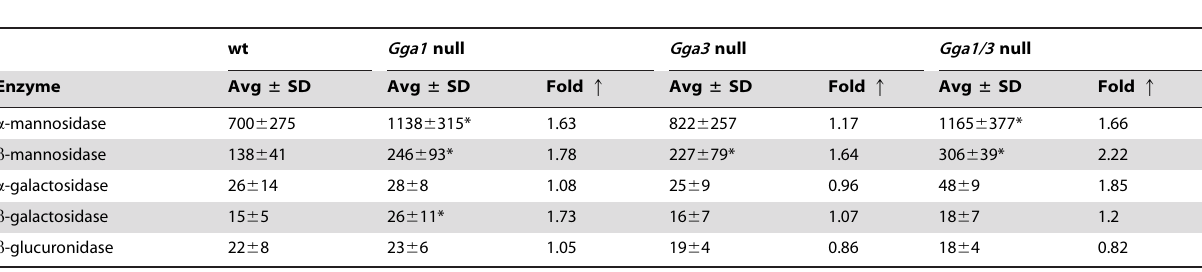
Enzyme activity is expressed as nmole product formed/h/ml. Fold q =null activity/wt activity. n=28 for all mice except the Gga1/3 null where n=10. *=p value ,